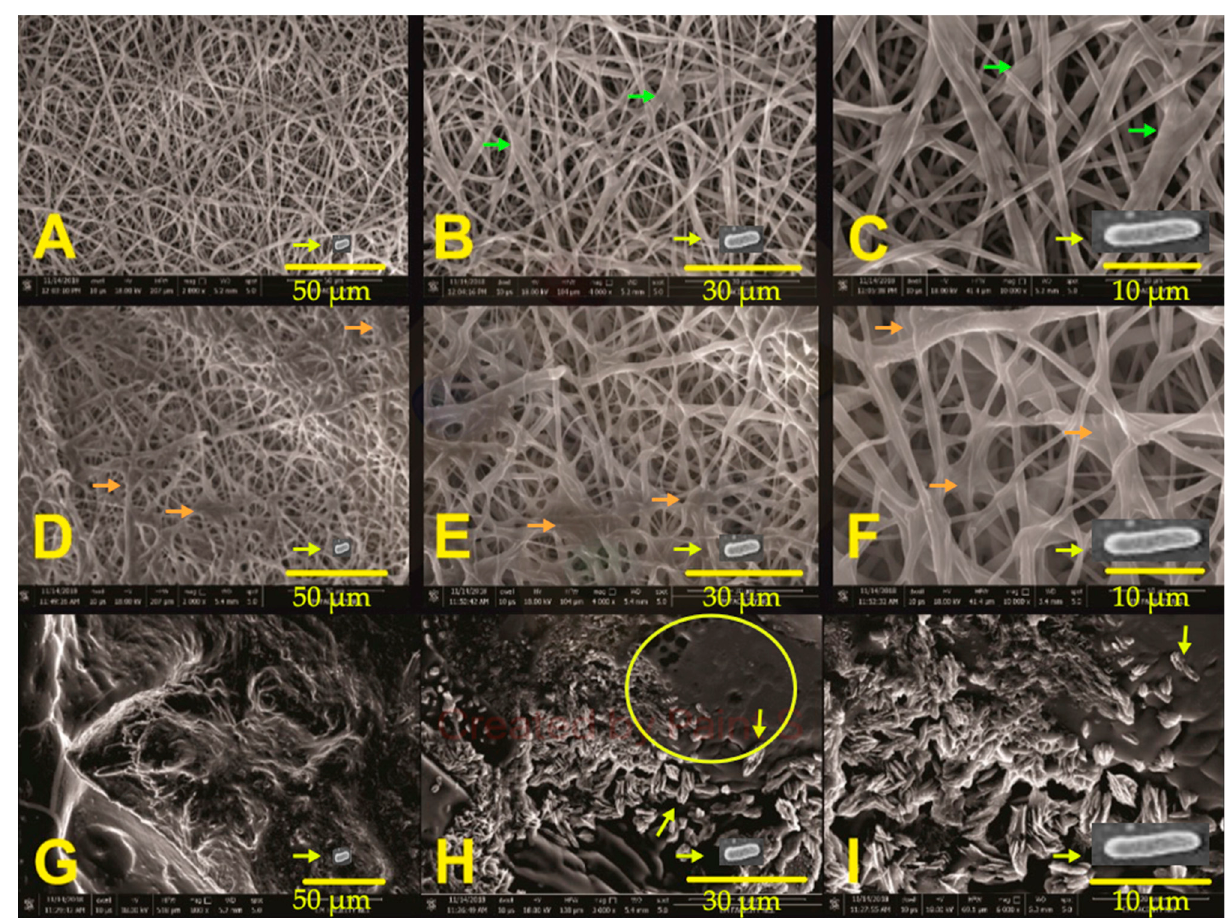
Figure 7. SEM micrograph of PCL/Glu fibers. First line ( A – C ) PCL/Glu fibers at 2000, 4000 and 6000× without inoculum after 6 h on MSB; second line ( D – F ) 2000, 4000 and 6000× after 3 h of growth with P. aeruginosa; and third line ( G – I ) 2000, 4000 and 6000× after 6 h of growth with P. aeruginosa on MSB .